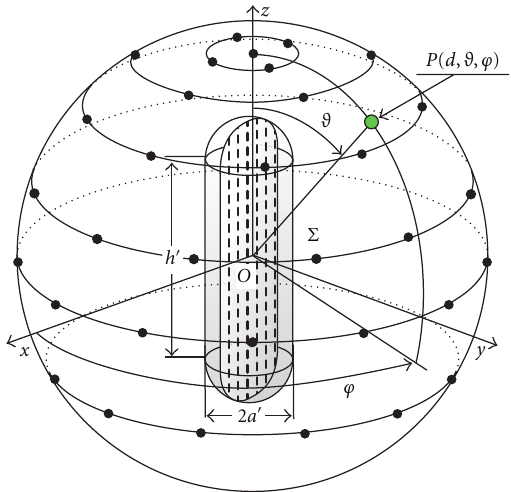
Figure 3: Spherical scanning for an elongated antenna.